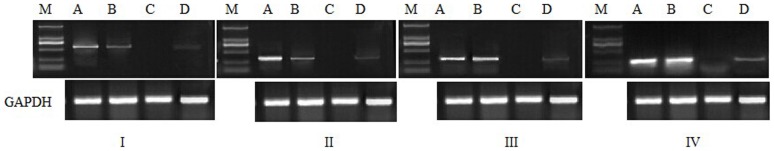
RT-PCR analysis for CSN2 (I), BT1N1A1(II), LTF(III), and BLG (IV) in YMECs.M: D2000 marker; A: yak mammary tissues (positive control); B: YMECs cultured in induction medium; C: fibroblasts (negative control); and D: YMECs cultured in basal medium.